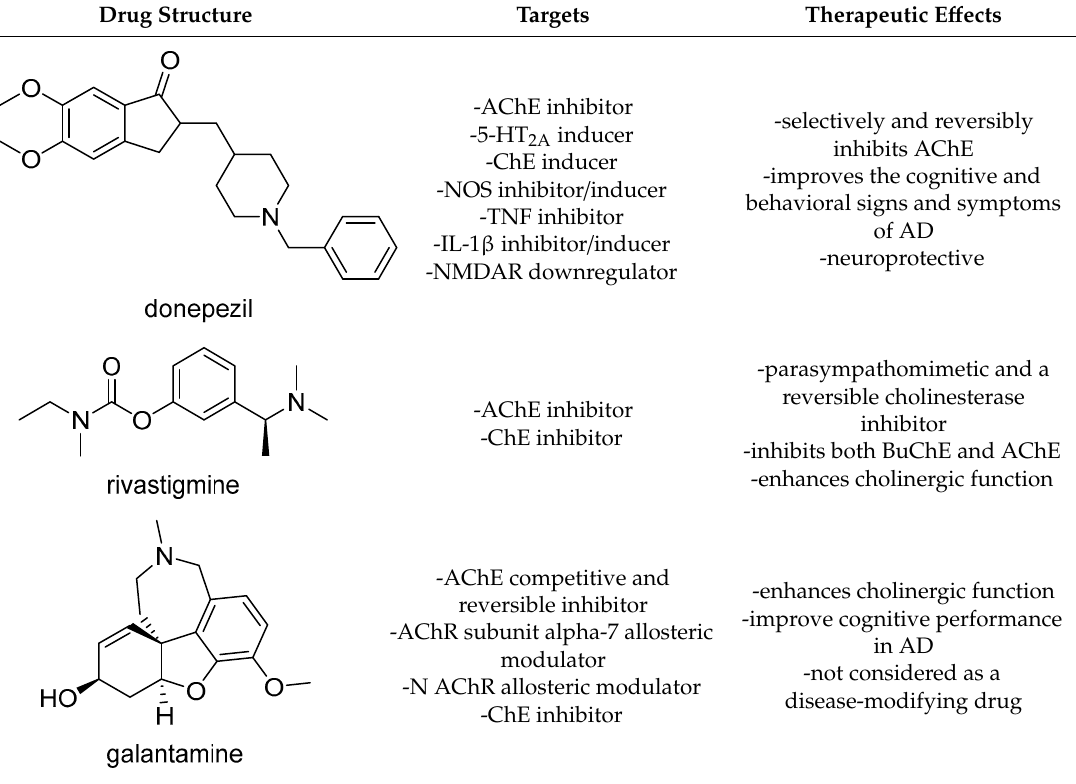
Table 1. Drugs approved for AD